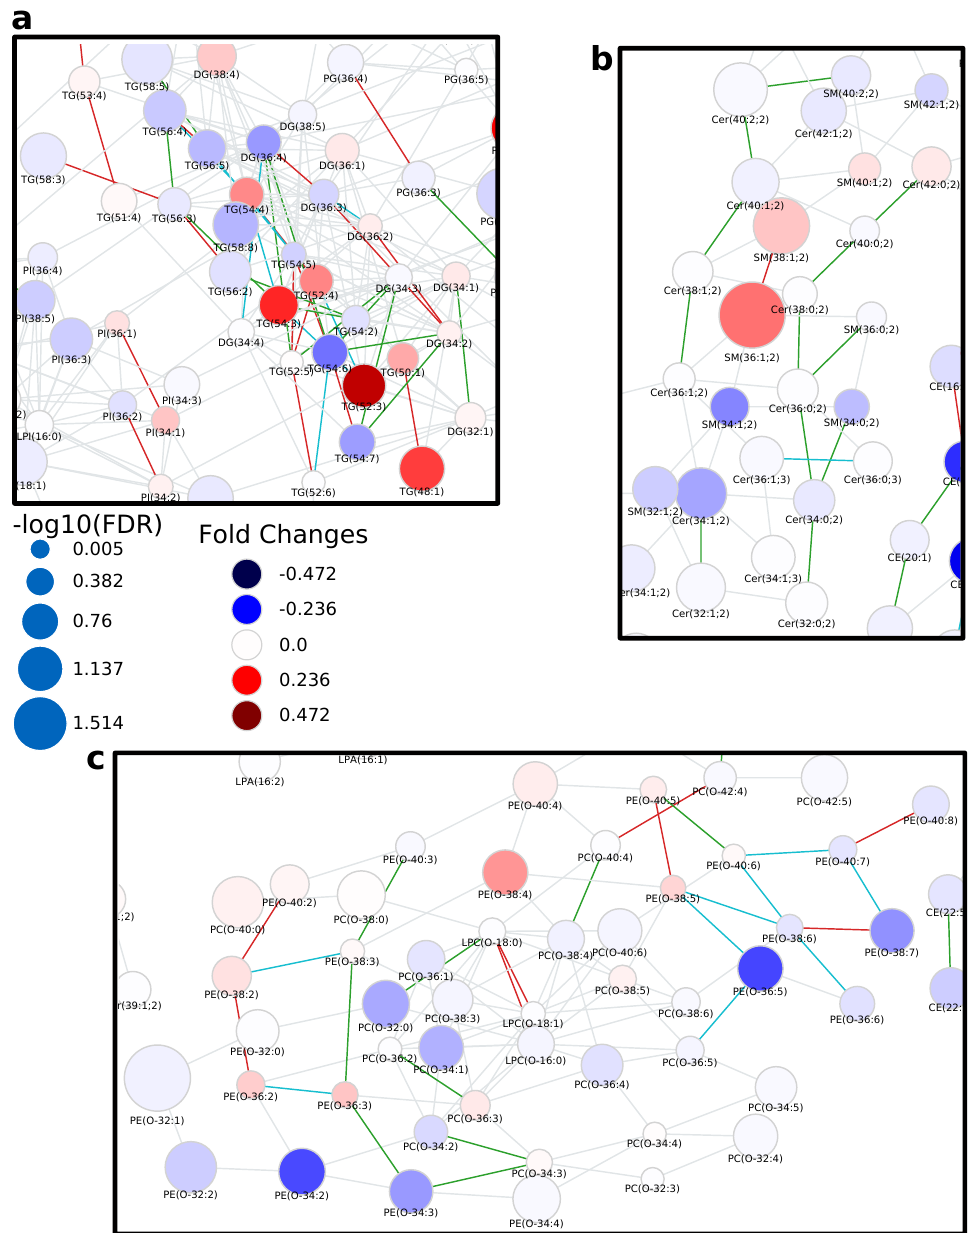
Figure A3. Detailed views on subnetworks of the lipidomics data of Wang et al. [16] showing the metabolism of ( a ) TG and DG, ( b ) ether lipids, and ( c ) sphingolipids. The full network can be seen in Figure 2. Nodes are colored by fold change and node size is scaled by − log10 of multiple testing corrected p -value. Edges are colored by correlation changes (see Figure